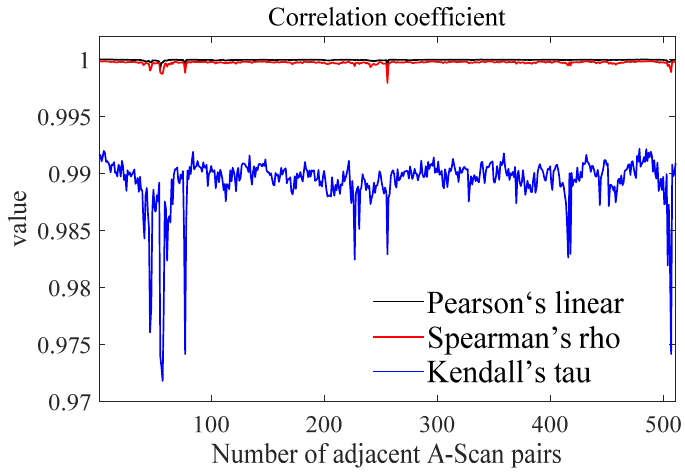
Figure 2. Correlation coefficients of the adjacent A-Scans in Figure 1.